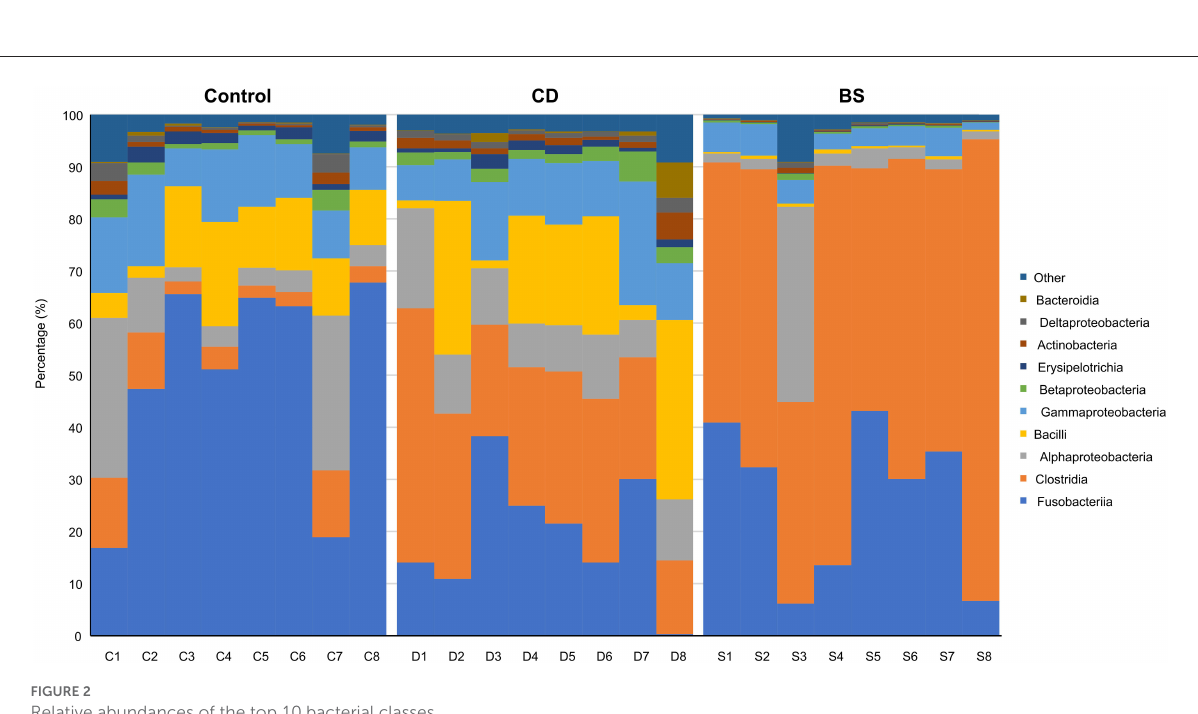
FIGURE2 Relative abundances of the top 10 bacterial